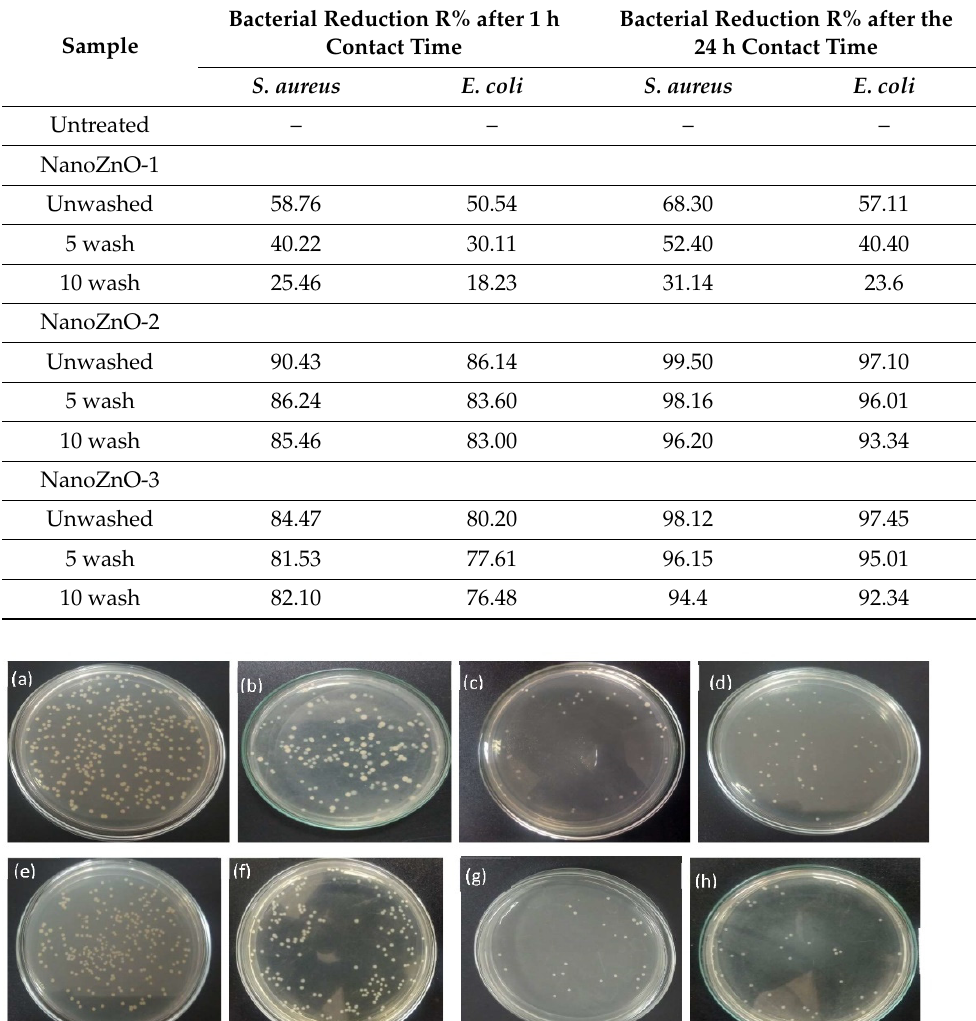
Table 2. Bacterial reduction on untreated and nano-treated fabric for S. aureus and E.coli .